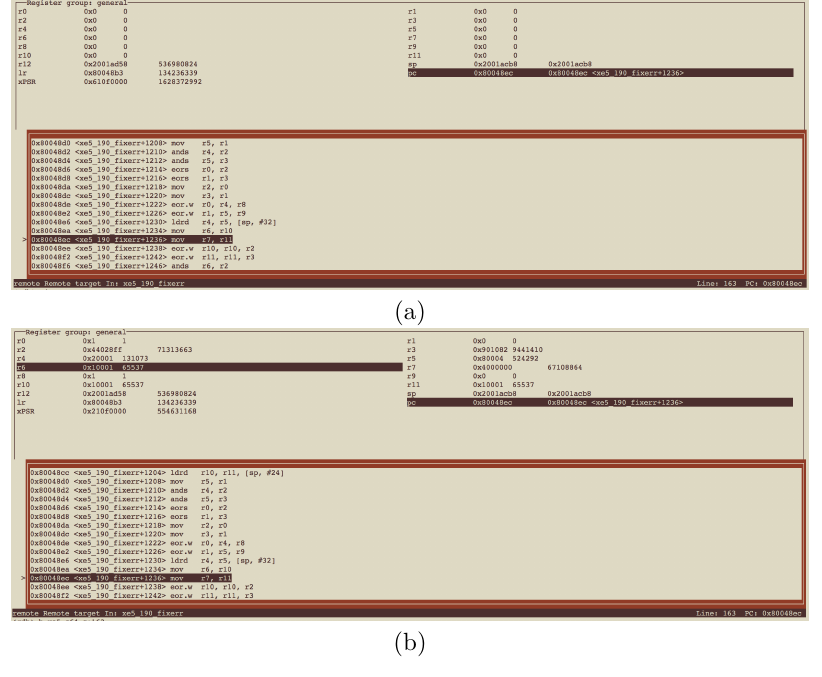
Figure 5: Visualization of internal registers during the targeted majority logic (a) Decoding of valid codeword c = 0 (b) Decoding of invalid codeword c =